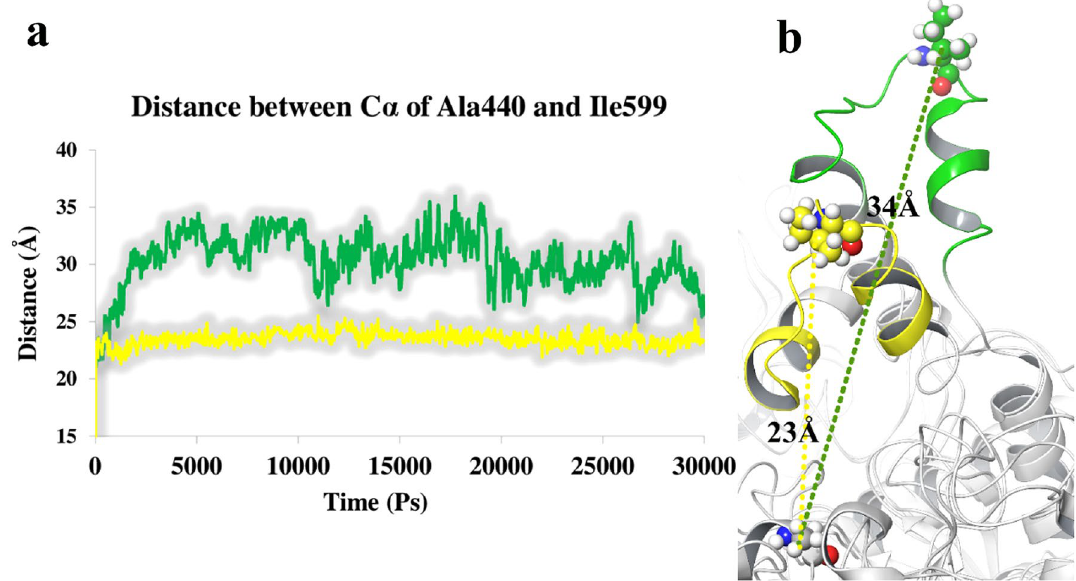
Figure 7. The distance between Ala440 and Ile599 urease residues when complexed with thiourea (green), and compound 3n (yellow) during the whole MD simulation time. ( a ) Representative snapshots of MD simulations where the active site flap adopts the open (urease-thiourea complex) and closed (urease-compound 3n ) conformations which depict in green and yellow color, respectively ( b